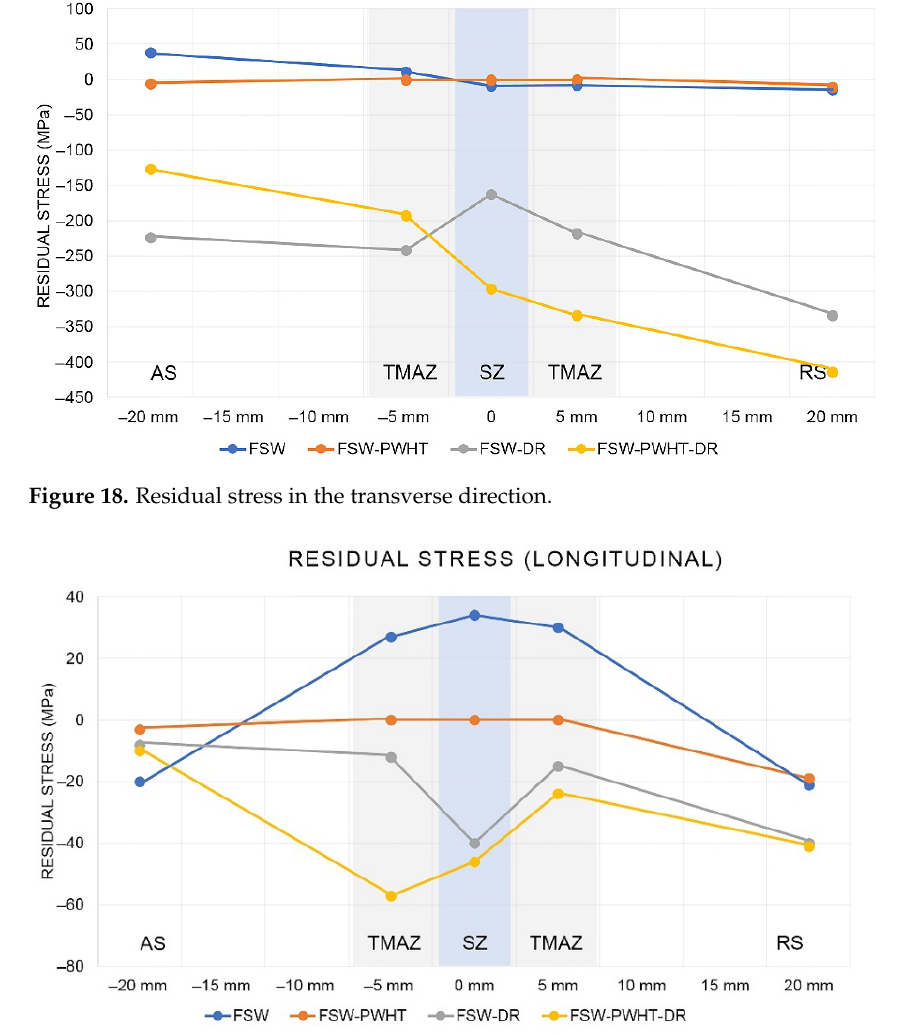
Figure 19. Residual stress in the longitudinal direction.